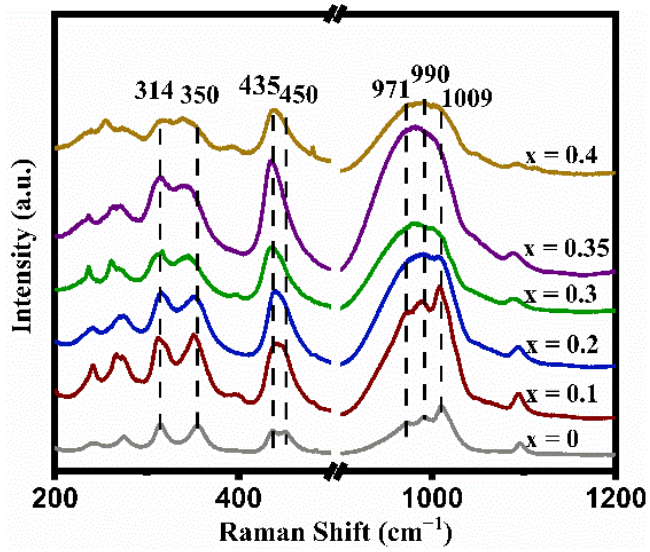
Figure 2. Raman spectra of LATP-xSn (x = 0–0.4) solid